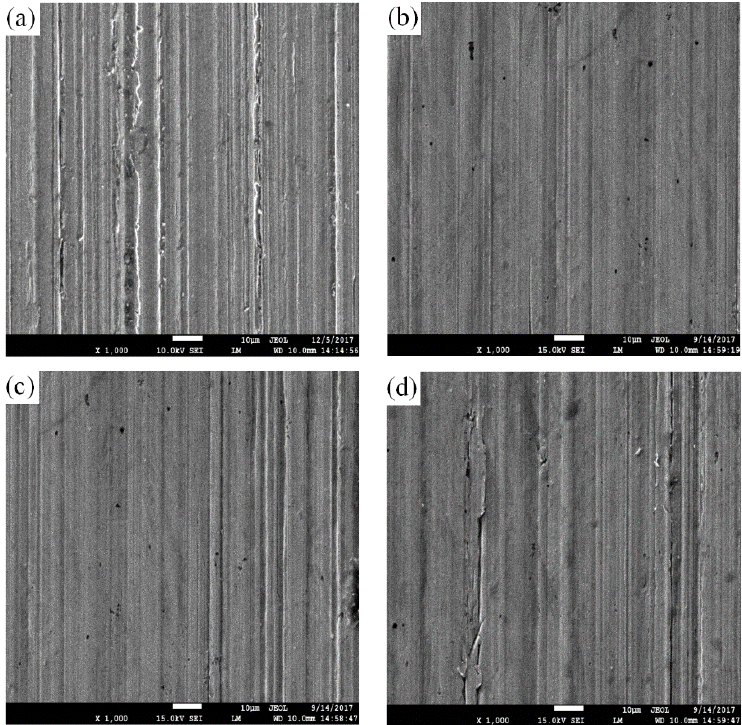
= 0.2; ( b ) x = 0.4; ( c ) x = 0.6; ( d ) x =